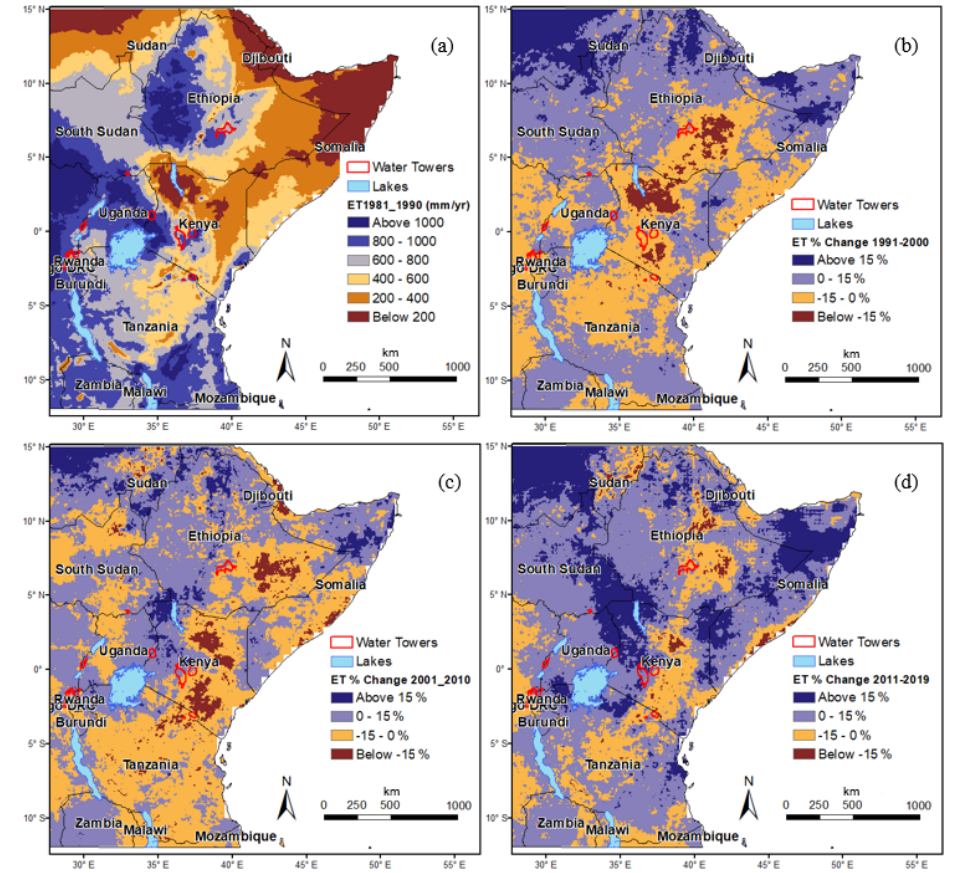
Figure 4. Distribution of simulated actual evapotranspiration in East Africa. (a) ET for 1981–1990, (b) ET changes in 1991–2000, (c) ET changes in 2001–2010, and (d) ET changes in